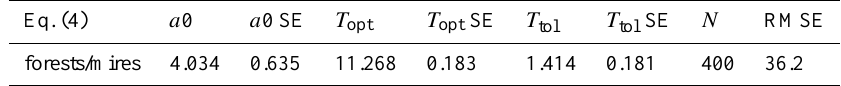
p < 0 . 001 for all